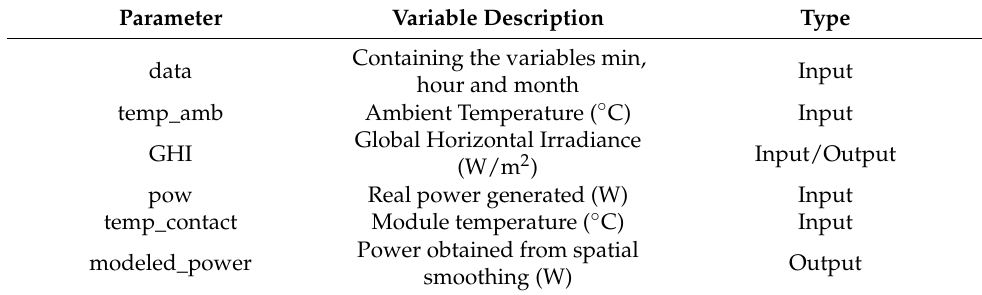
Table 4. Variables used in the